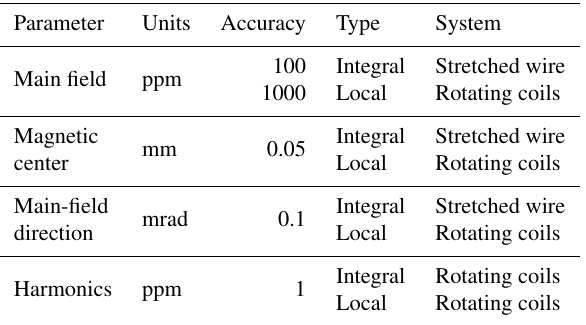
Table 2. Existing systems accuracy (Bottura et al., 2006; DiMarco et al., 2013, 2000; Perez et al.,